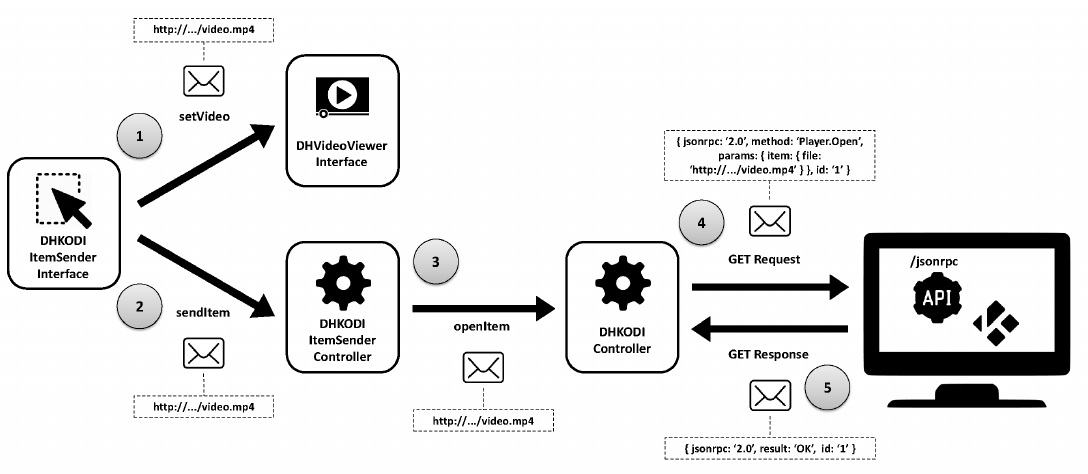
Figure 8. Communications of interaction human-to-human (first